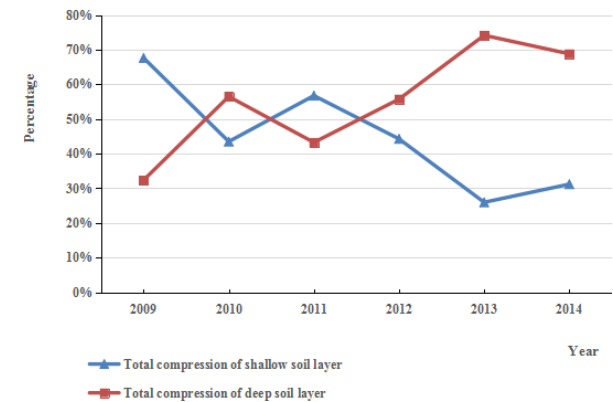
Figure 6. Annual total settlement percentage line chart of the shal- low and deep soil layers (2009–2014).